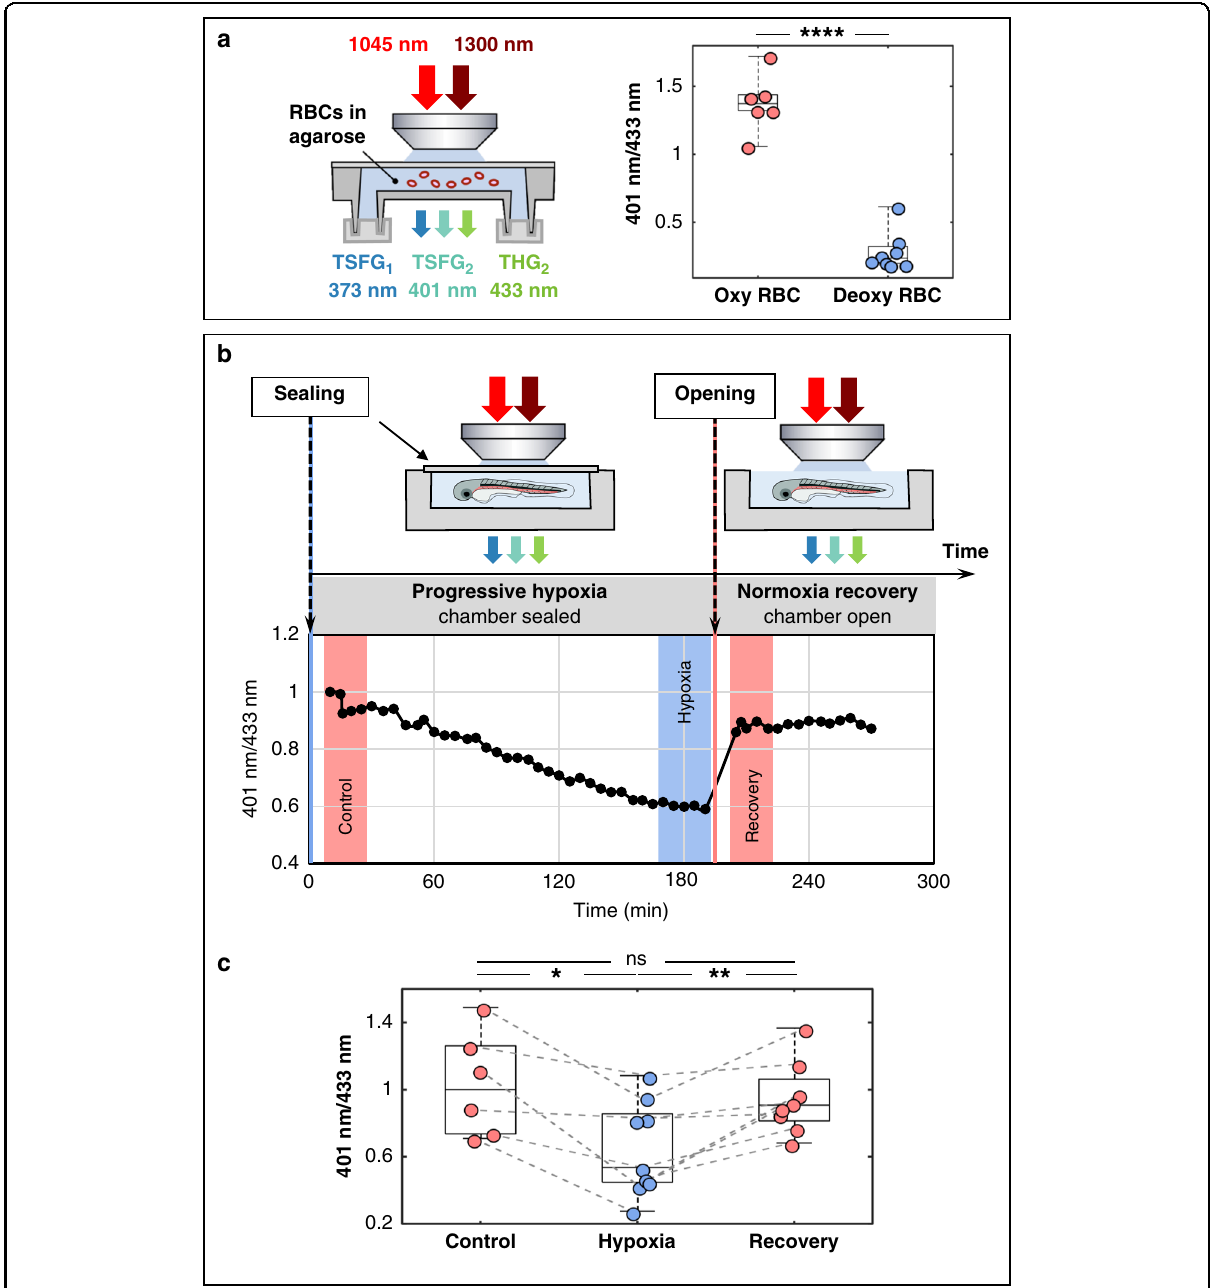
Fig. 4 Probing RBC oxygenation state with color TSFG microscopy. a Experimental setup and measured S 401 /S 433 TSFG signal ratios for isolated zebra fi sh RBCs in oxygenated ( N = 6) and deoxygenated ( N = 8) states. p ≤ 0.0001 (unpaired two-tailed Whelch ’ s test). b Oxygenation dynamics measured on fl owing RBCs in a 2 dpf zebra fi sh. The S 401 /S 433 ratio was measured every 5 min during progressive hypoxia in a sealed chamber and after chamber opening. c Evolution of the S 401 /S 433 ratio during reversible hypoxia experiments for N = 9 different embryos. The values are the average of several points spanning 25 min as in the colored regions shown in the graph in b . The values were normalized by setting the median of the control to 1. One star: p ≤ 0.05; two stars: p ≤ 0.01 (mixed-effects